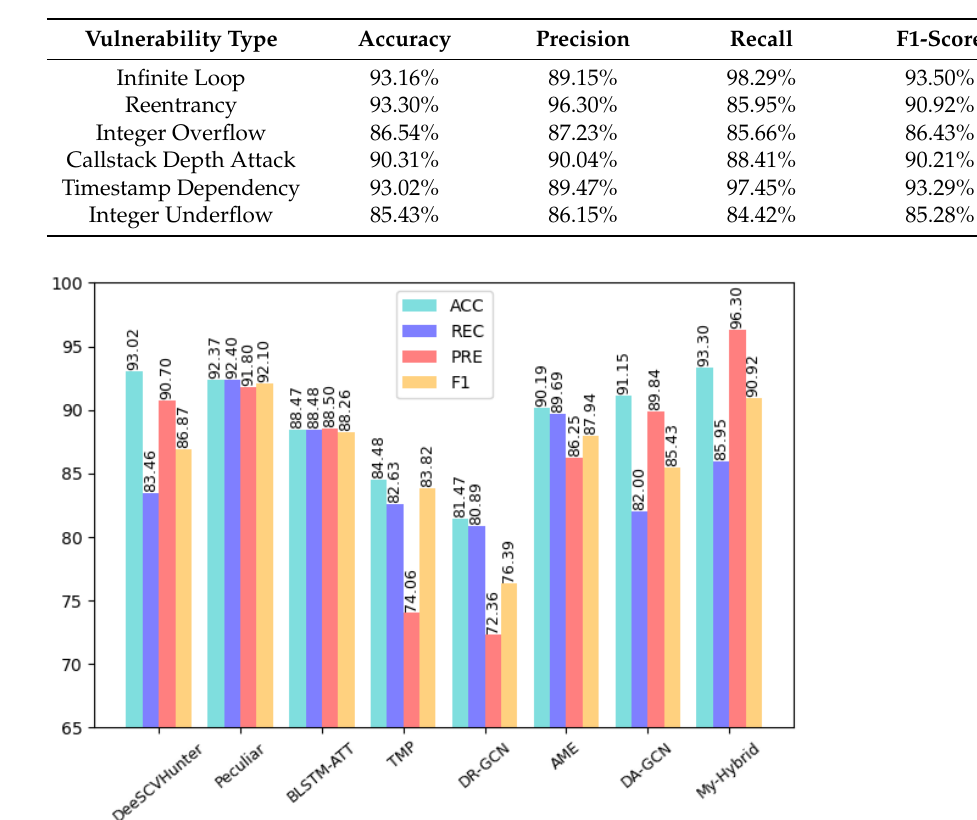
Figure 13. Timestamp vulnerability detection results.